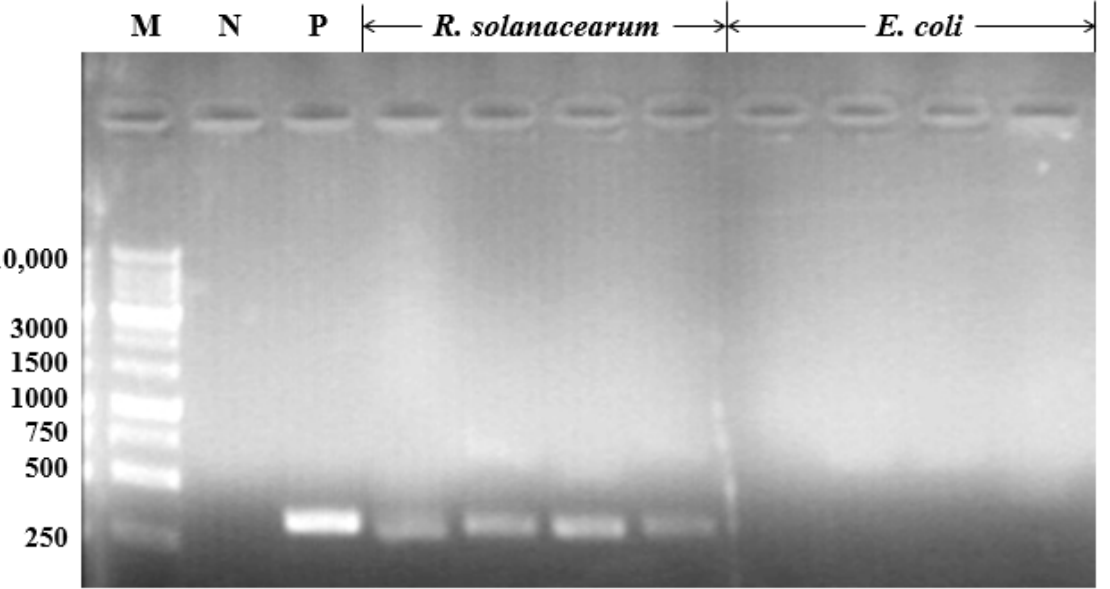
Figure 1. Immuno-PCR was used to detect the specific targeting effect of the antibody on R. solanacearum . Test templates of water and R. solanacearum bacterial solution were used as the negative control (N) and the positive control (P), respectively.